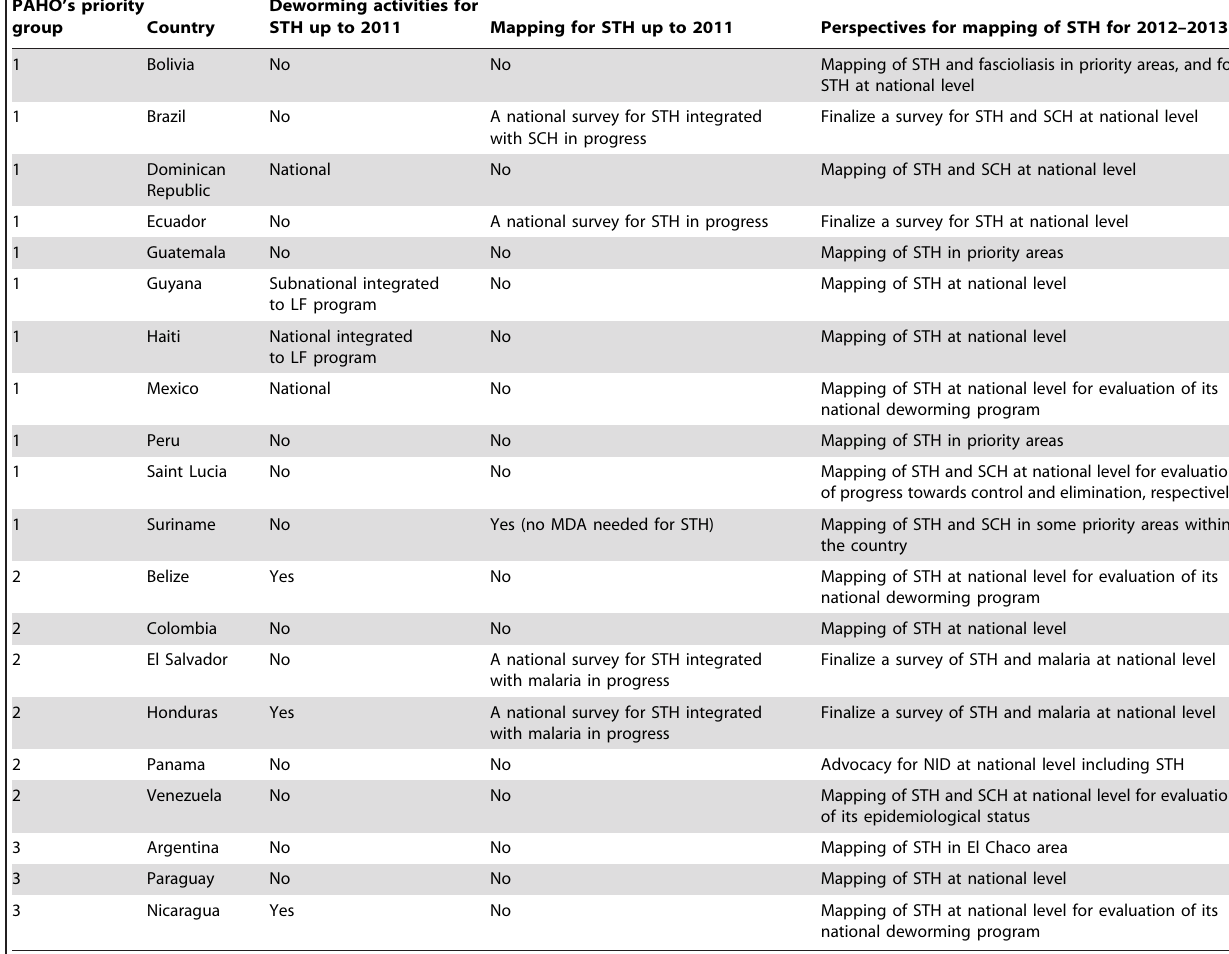
PAHO’s priority